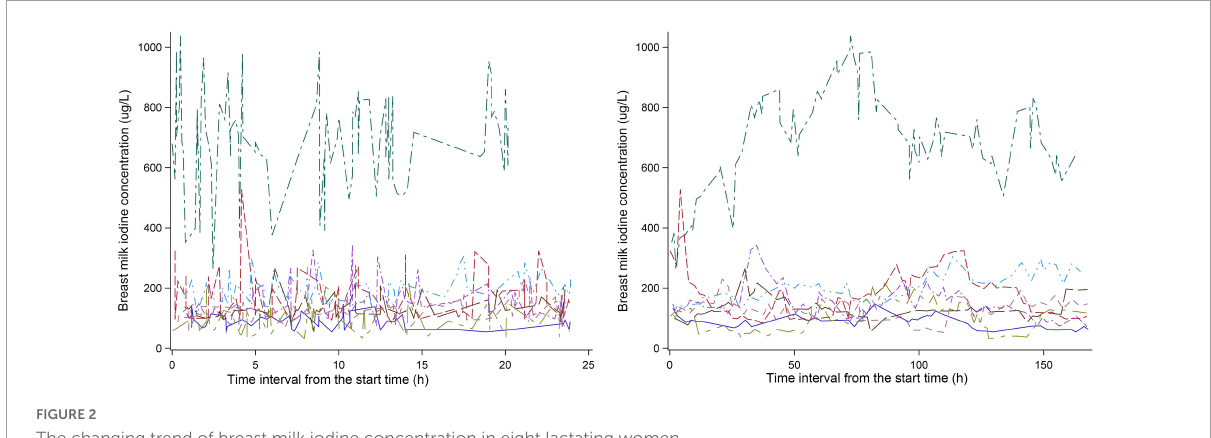
FIGURE2 The changing trend of breast milk iodine concentration in eight lactating women.